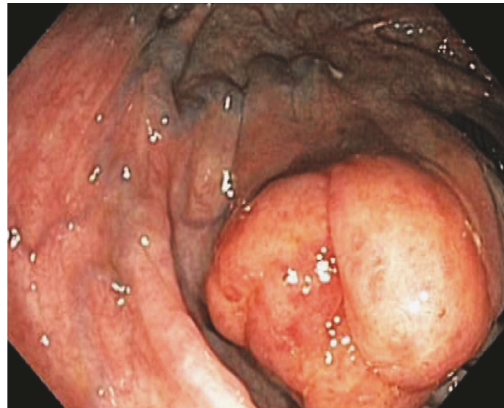
Figure 22: Endoscopic imageof ileocecumshowing mucosal edema, mild loss of mucosal vascularpattern,patchyerythema, vascularectasia, and varices. The ileocecal valve is edematous in the left lower corner.